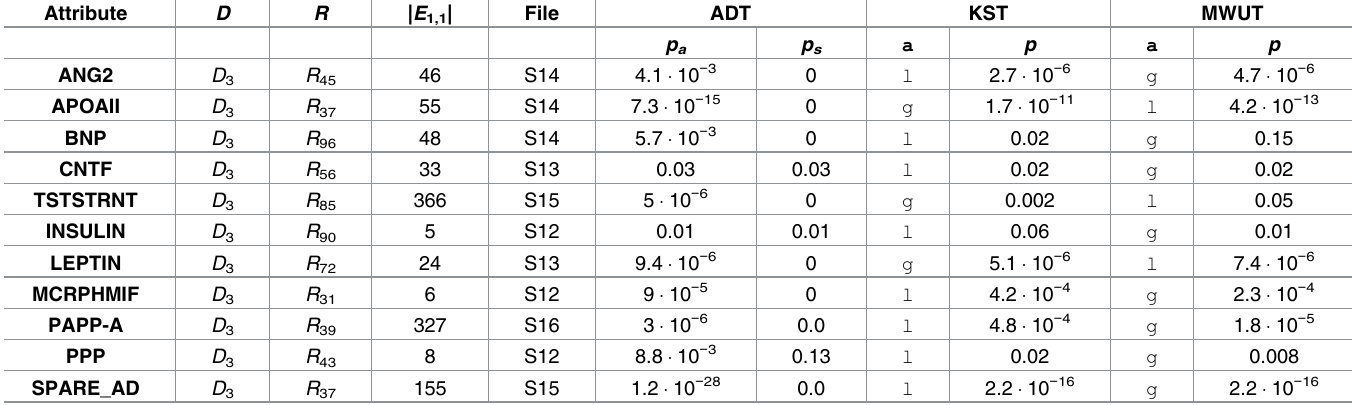
Table 5. Attributes analysed in this section with corresponding example redescription containing this attribute. For each selectedattribute we pres- ent exampleredescription that describessubjects with statistically significantdifference in attribute value distributioncomparedto a group of CN subjects.